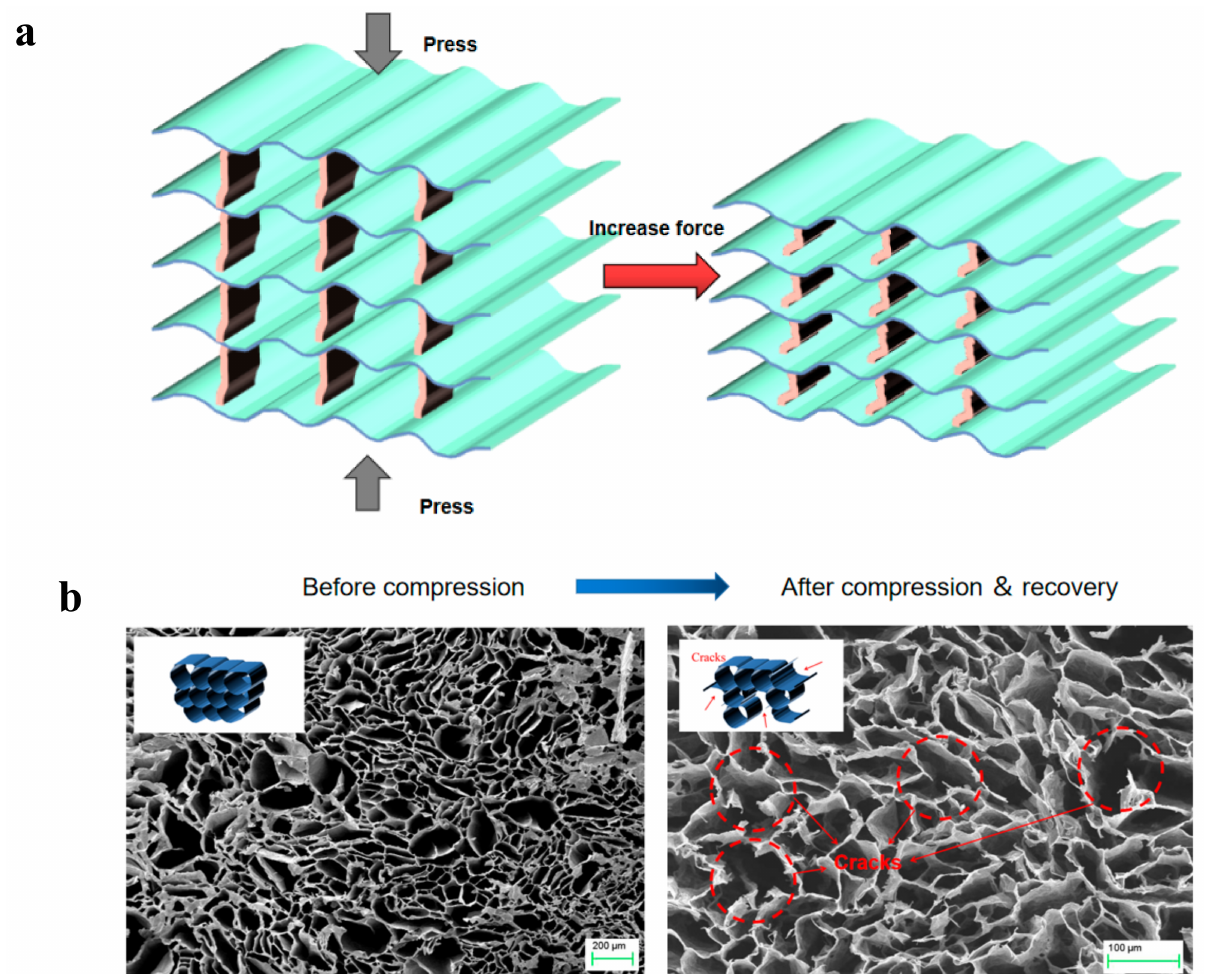
Figure 6. ( a ) Schematic diagram of the mechanism of the high compressibility and recoverability of biomimetic mineral bridge structures. ( b ) SEM image showing the r-MGTPA with random structure before and after 100 cycles of compression (strain = 60%) and recovery. Inserts show the corresponding